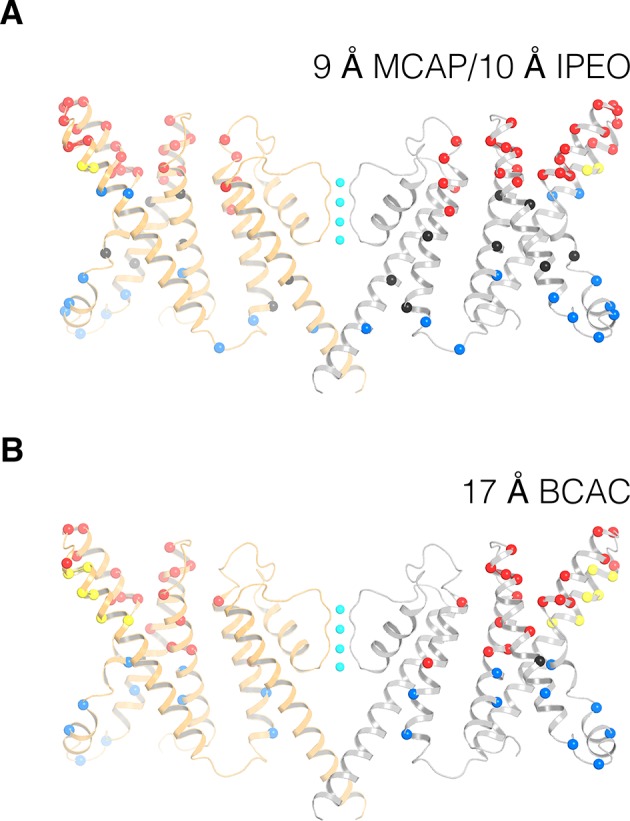
Remapping biotin-avidin accessibility data onto the KvAP cryo-EM structure.(A,B) Remapping previous data on tethered biotin-avidin accessibility with 9–10 Å (panel A) and 17 Å (panel B) effective tether lengths onto the cryo-EM structure of KvAP (Ruta et al., 2005; Banerjee and MacKinnon, 2008). Only two opposing subunits (gray and orange ribbons) are shown for clarity. Red and blue spheres represent positions accessible to the extracellular and intracellular sides of the membrane, respectively. Black spheres represent positions inaccessible to either side of the membrane. Yellow spheres represent positions accessible to both sides of the membrane.